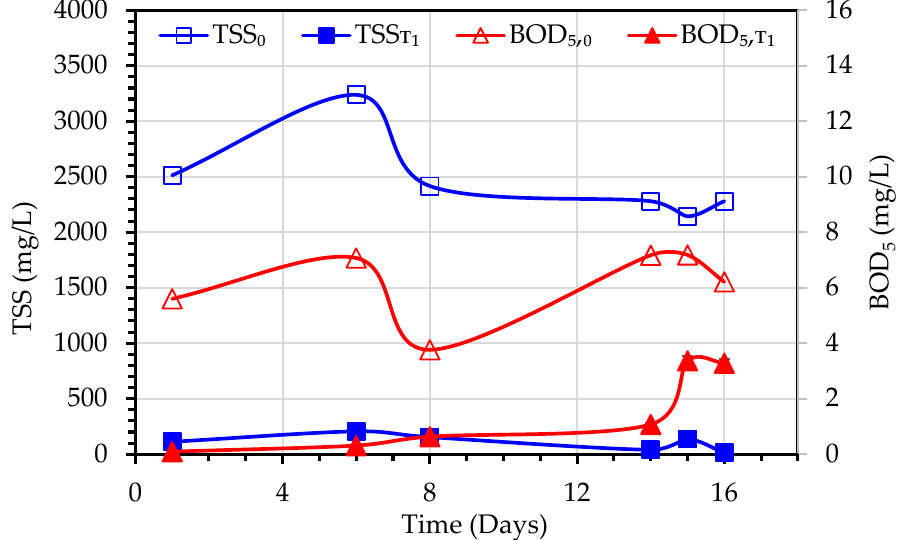
Figure 8. Variations of BOD 5 and TSS values observed during the treatment of primary wastewater using a hybrid MBBMR and DCMD system (Experiment 2).